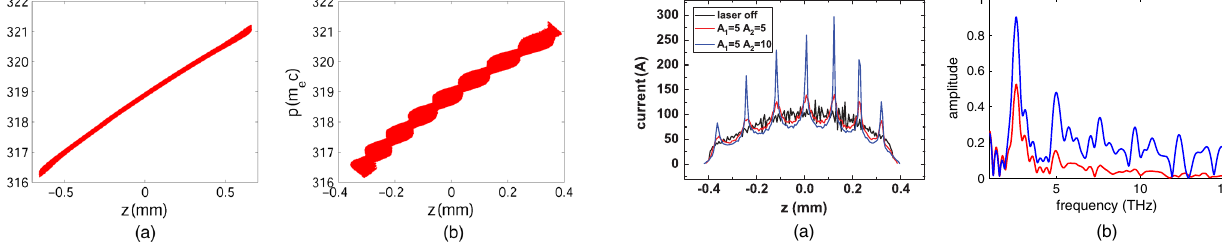
FIG. 8. Longitudinal phase space of the beam at two important locations. (a) Exit of modulator 1; and (b) exit of modulator 2.